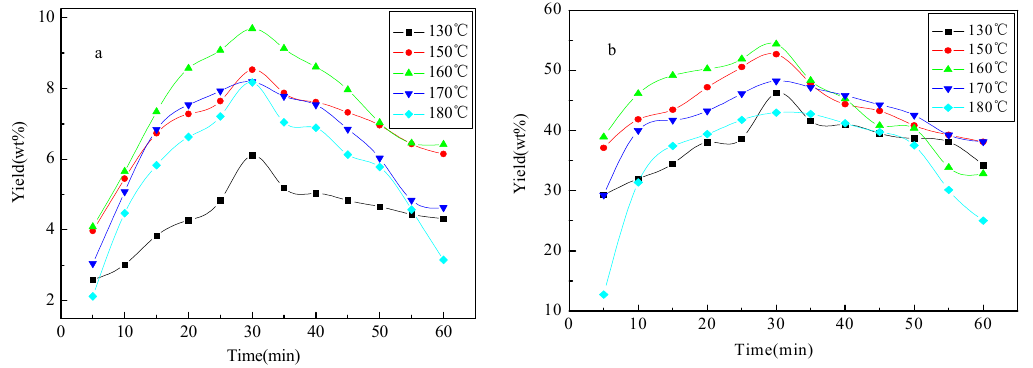
Figure 1. Yield of liquid products under different reaction temperatures and reaction times. ( a ) yield of bio-oil 1; ( b ) yield of bio-oil 2.